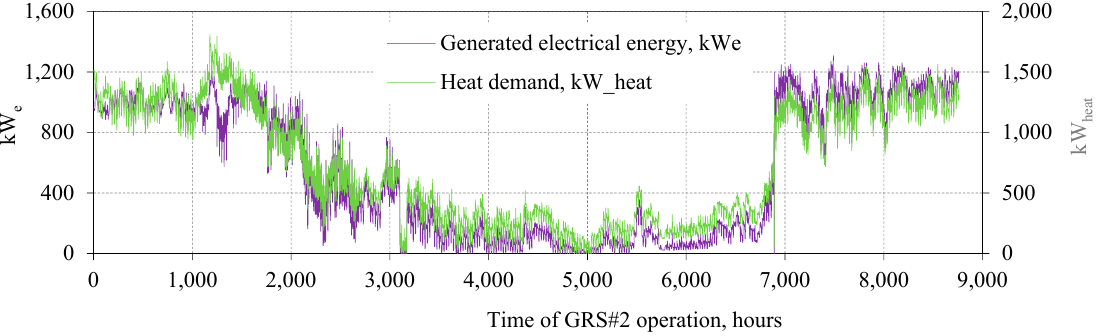
Figure 9. Expander efficiency for GRS #1 over a period of one year.